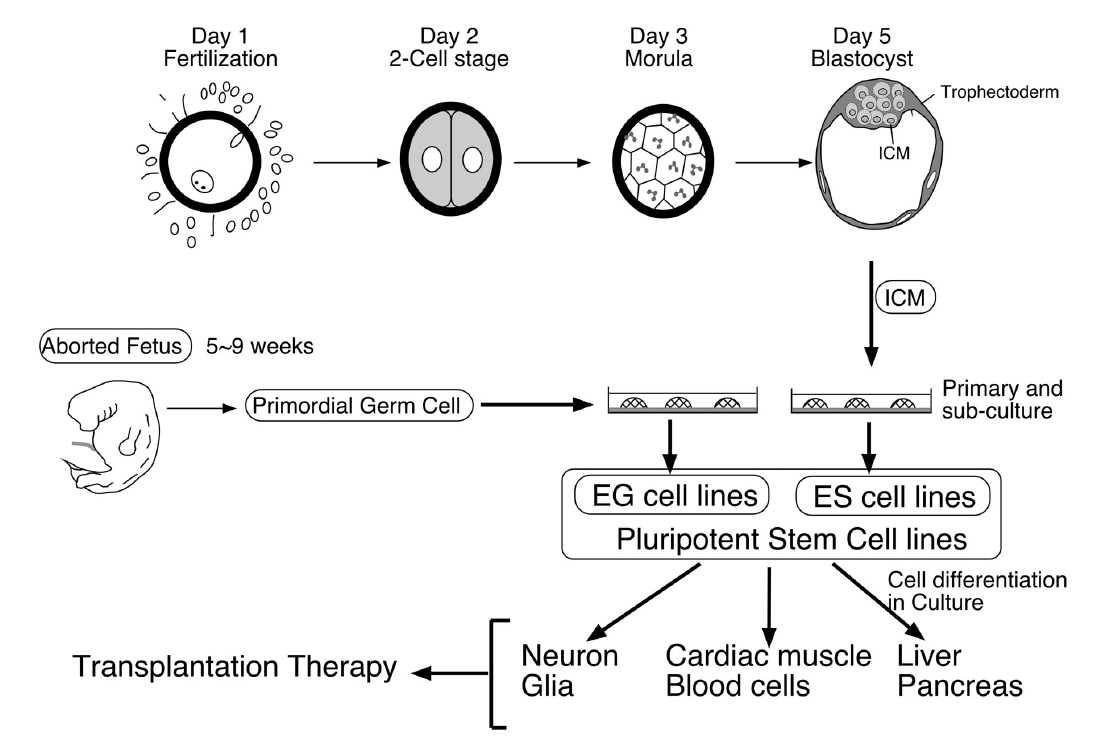
FIGURE 1 . A diagram showing establishment of human ES cell lines from blastocysts and that of EG cell lines from fetal germ cells. Such pluripotent cell lines can be maintained and grown for a long period in culture and induced to differentiate into various cell types, which can be used for cell transplantation therapy and other purposes in medical research.